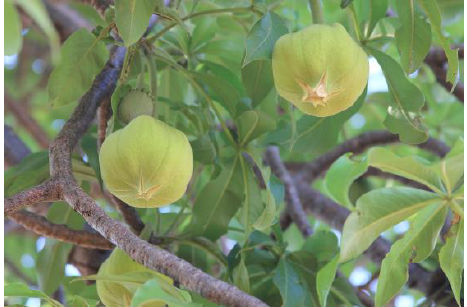
Figure C2. An open baobab flower. Figure A1. The bud on the right is cracked on the bottom, indicating that the flower will open that